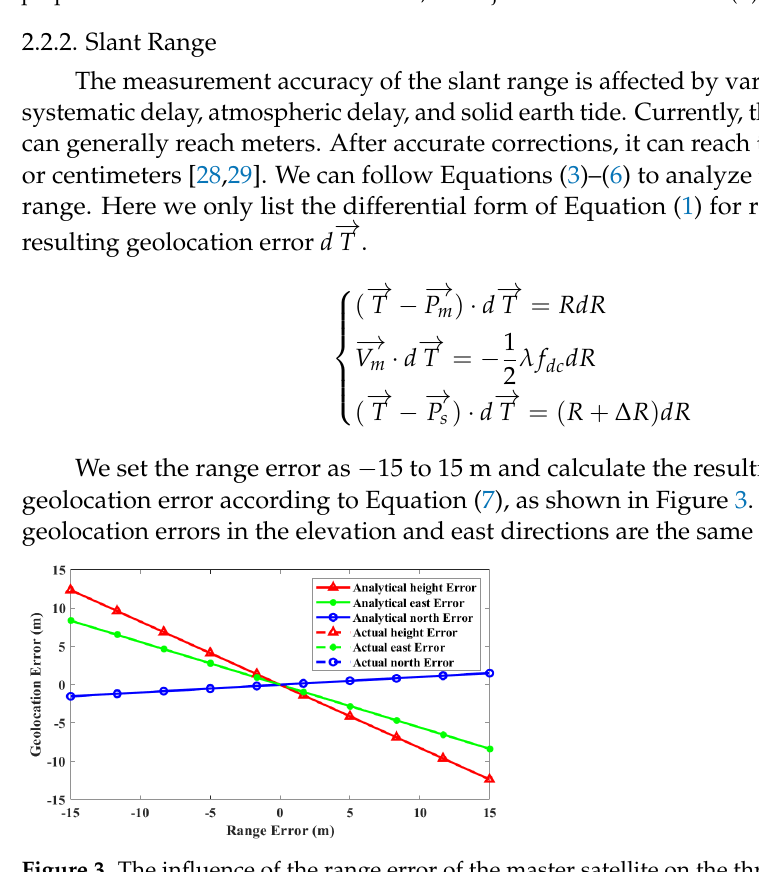
Figure 2. The influence of the ( a ) along-track, ( b ) perpendicular and ( c ) parallel spacial baseline error on the three-dimensional geolocation accuracy. It should be noted that since the impact of perpendicular baseline error is too small, we adjust the ordinate unit of ( b ) to millimeters.